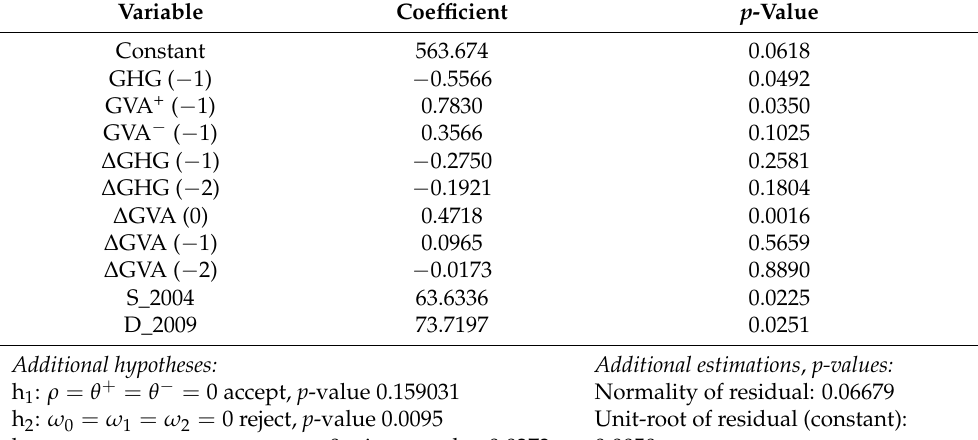
Table 6. NARDL results for Estonia.